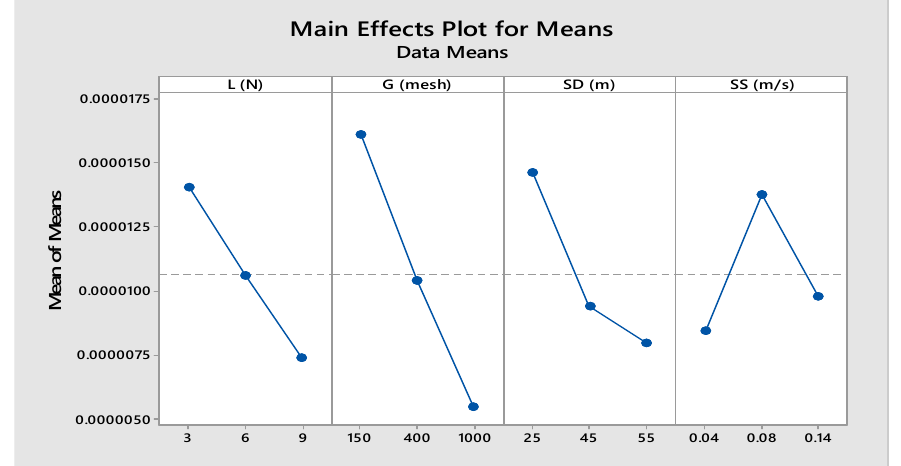
Figure 9. Main effect plot for mean μ of PTFE matrix composites.